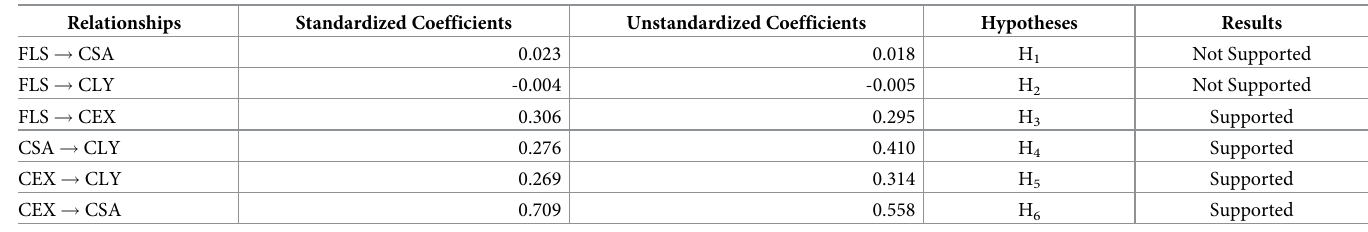
Table 3. Hypotheses test